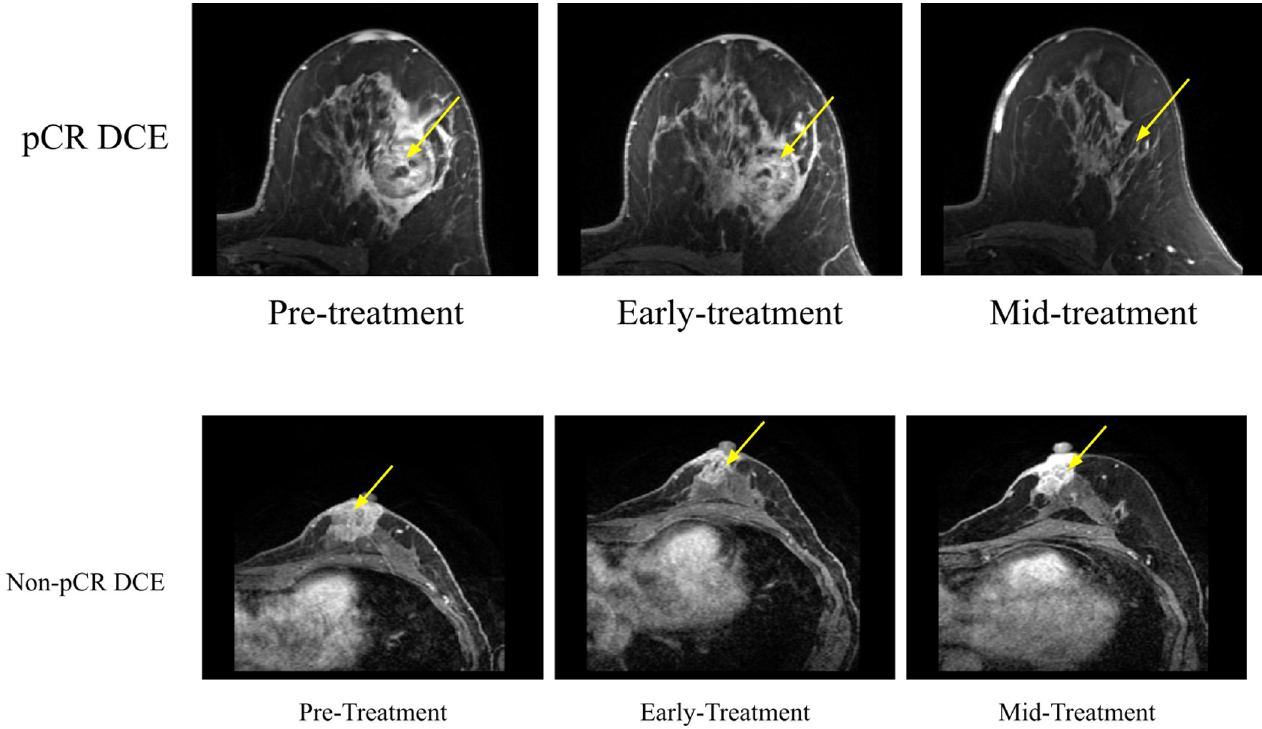
Fig 3. Post-contrast MRIs from DCE for (A) a pCR patient and (B) a non-PCR patient at the pre-treatment, early treatment, and mid-treatment time points. For (A), the 54 year old Caucasian patient had invasive ductal carcinoma with HR- and HER2-. For (B), the 51 year old Caucasian patient had invasive ductal carcinoma with HR+ and HER2-. The yellow arrow indicates the approximate location of the tumor. MRI images were taken approx. 2.5 minutes after contrast injection with a phase duration of 80sec < phase duration < 100sec. pCR: complete pathological response, DCE: dynamic contrast enhanced.